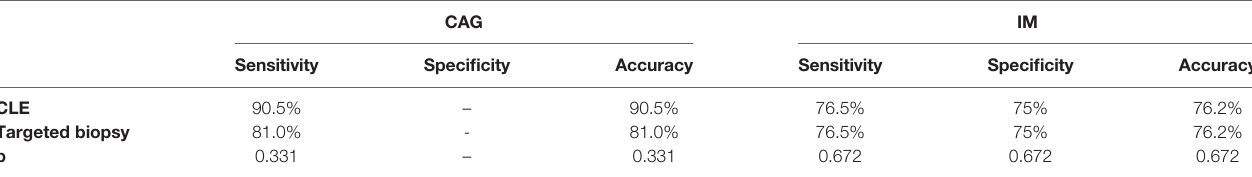
TABLE 3 | Diagnostic ef fi ciency of CLE and targeted biopsy on CAG and